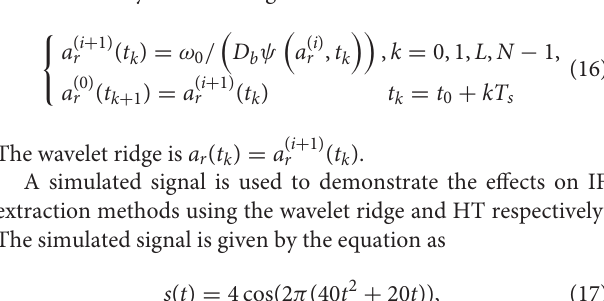
Frontiers in Earth Science |